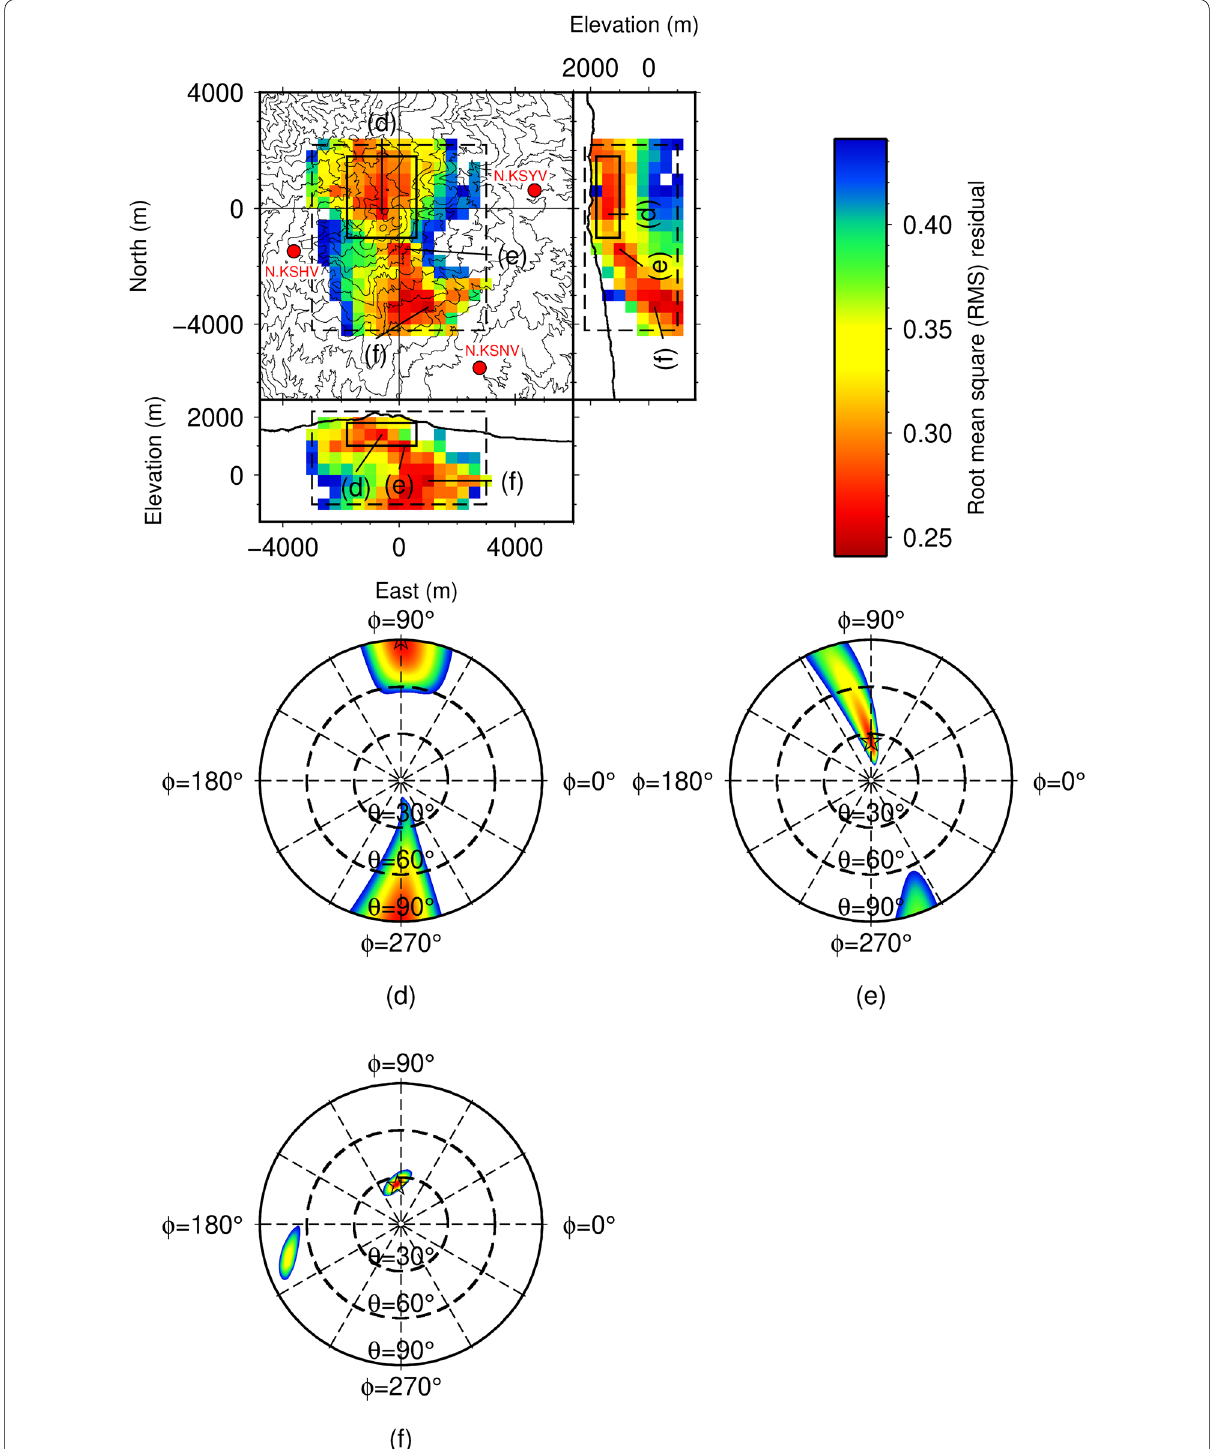
Fig. 6 Spatial distribution and crack orientation dependence of the RMS residuals between the observed and synthetic waveforms obtained by waveform inversion using the three-component broadband seismograms at the three stations except for the NS component at N.KSHV (eight components). The locations of candidates ( d ), ( e ) and ( f ) are indicated by straight lines on the plane map. See Fig. 5 for details concerning the plotting